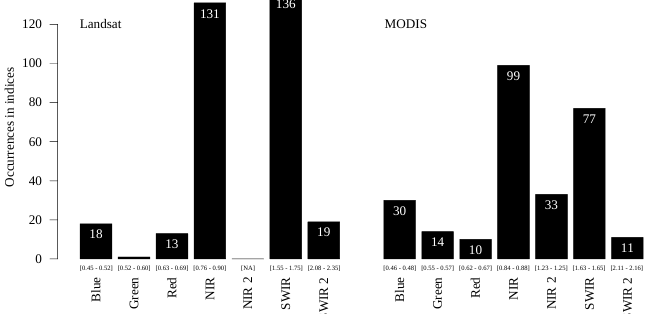
Figure 14. Distribution of the frequencies of the spectral bands of the learned indices for forest/savanna discrimination.